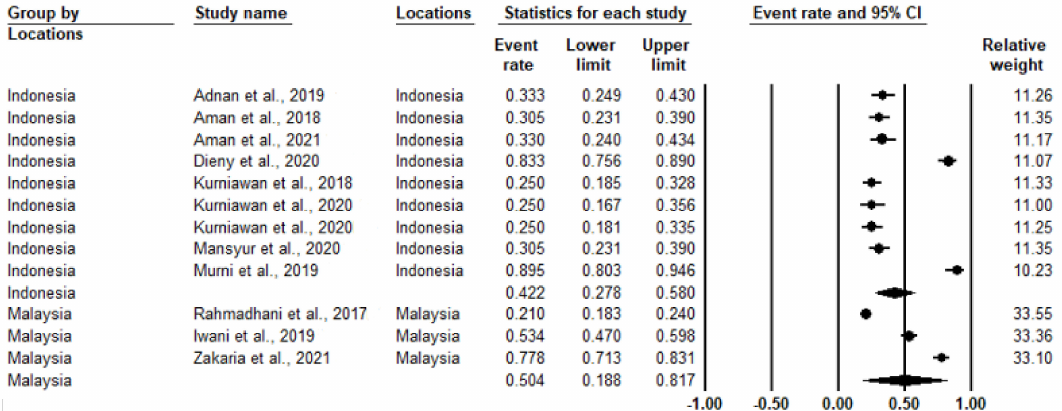
Figure 3. The insulin resistance prevalence grouped according to country using random-effects model as illustrated by the forest plot. The filled round circle is the prevalence of IR with 95% CI. The filled diamond represents the overall prevalence for subgroups [18–29].